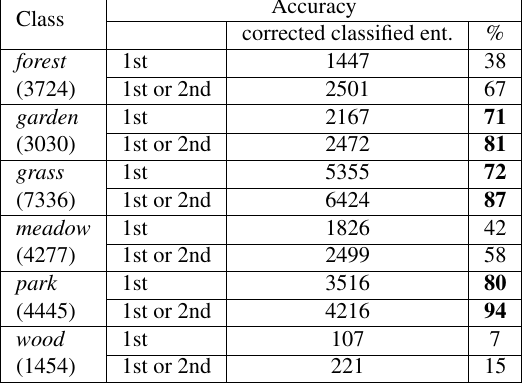
Table 3: Proposed classifier accuracies per class